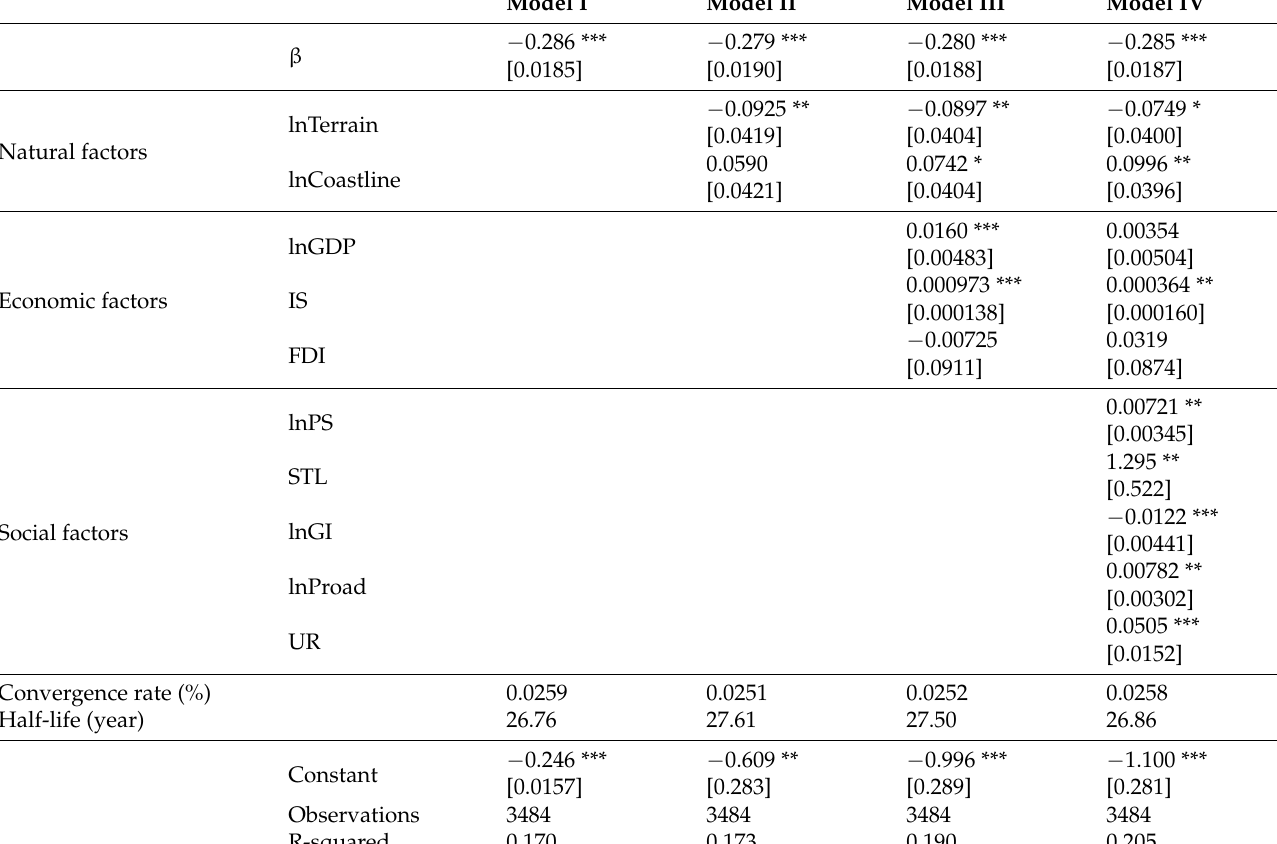
Table 3. Convergence analysis of USI among all cities.